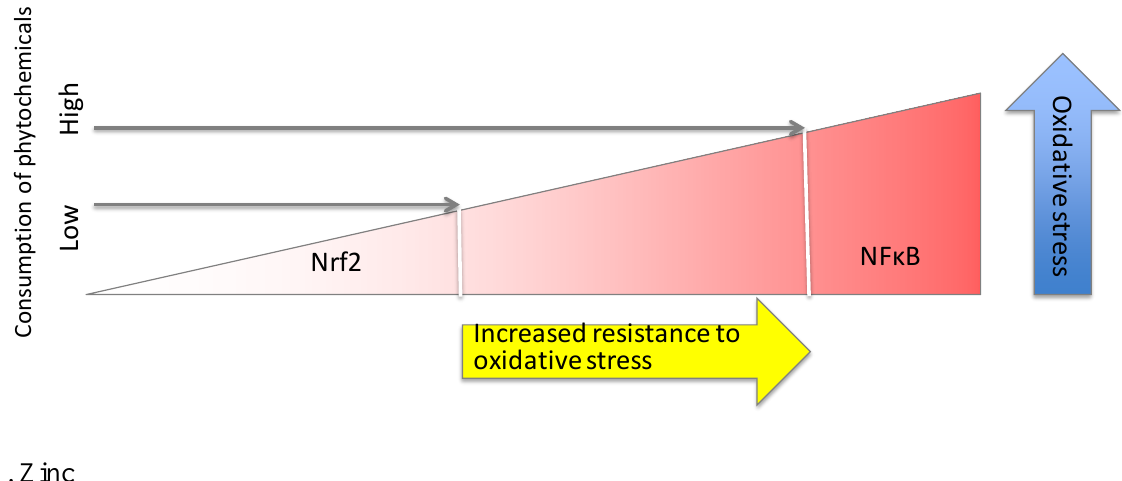
Figure 4. Phytochemical-rich diet increases resistance to oxidative stress and protects against